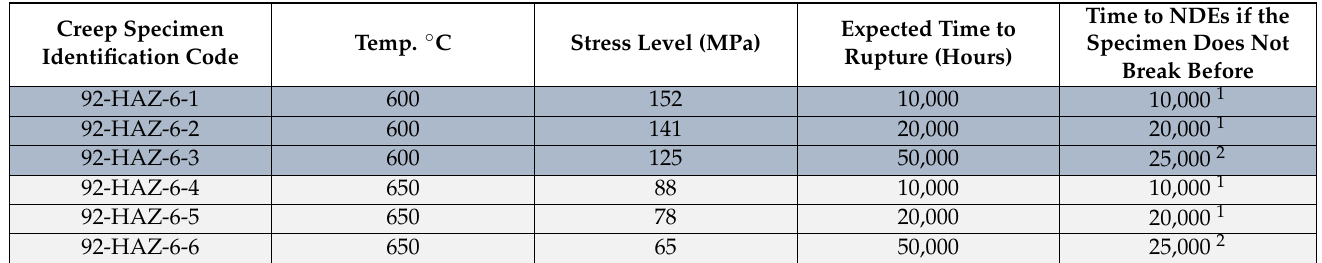
Table 6. Creep test program of sub project N ◦ 6: 6 GR 92 HAZ creep; the last column is the schedule for the other tests to be performed on the creep specimen (after the specimen rupture or after the number of hours indicated in the last